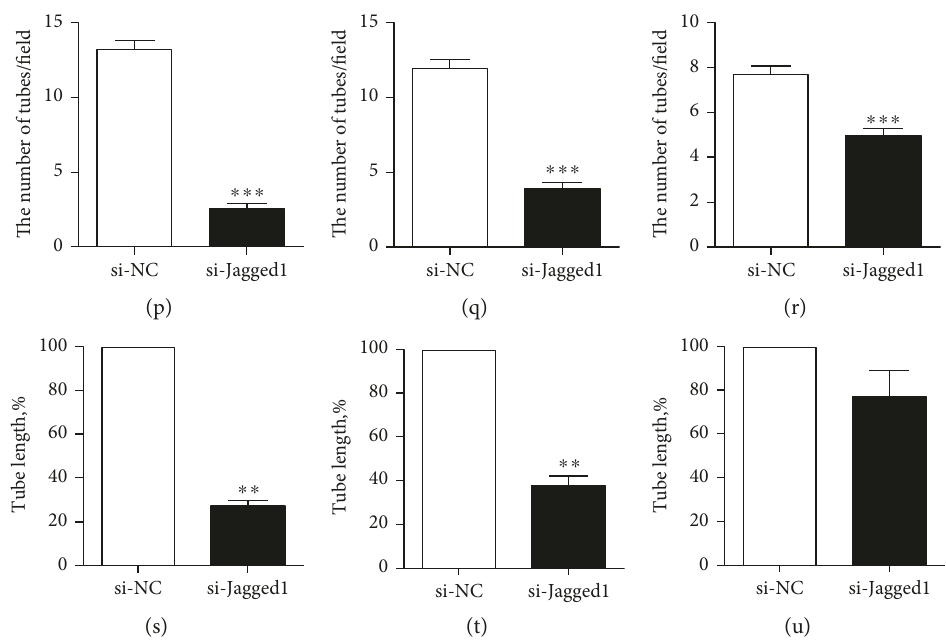
Figure 7: Knockdown of Jagged1 decreased tubule-like structures formation in the umbilical cord artery perivascular stem cells (UCA-PSCs), umbilical cord vein perivascular stem cells (UCV-PSCs), and Wharton ’ s jelly mesenchymal stem cells (WJ-MSCs). (a – i) Jagged1 knockdown was e ff ective. qRT-PCR analysis of Jagged1 mRNA levels in UCA-PSCs (a), UCV-PSCs (b), and WJ-MSCs (c) 48 h after the transfection with negative control siRNA (si-NC) or Jagged1 siRNA (si-Jagged1). ∗∗ P < 0 01 , si-Jagged1 versus si-NC; ∗∗∗ P < 0 001 , si-Jagged1 versus si-NC; ∗ P < 0 05 , si-Jagged1 versus si-NC. Western blot analysis of Jagged1 expression in UCA-PSCs (d), UCV-PSCs (e), and WJ-MSCs (f) 72 h after the transfection with si-NC or si-Jagged1. Quantitative analysis of Jagged1 protein expression levels in UCA-PSCs (g), UCV-PSCs (h), and WJ-MSCs (i) 72h after the transfection with si-NC or si-Jagged1. Data are representative of three independent experiments performed in triplicate, and the expression of targeted protein was relative to the expression of GAPDH protein. ∗∗ P < 0 01 , si-Jagged1 versus si-NC; ∗ P < 0 05 , si-Jagged1 versus si-NC. Knockdown of Jagged1 decreased angiogenesis in UCA-PSCs, UCV-PSCs, and WJ-MSCs in vitro. (j – o) Representative images of tubular structures. Bar: 50 μ m. Tube formation assays were performed 72h after transfection of si-NC or si-Jagged1. The number of tubes in UCA-PSCs (p), UCV-PSCs (q), and WJ-MSCs (r), together with the total length of tubes per fi eld in UCA-PSCs (s), UCV-PSCs (t), and WJ-MSCs (u) were quanti fi ed 3 h after treatment by counting 3 – 5 random fi elds/well under the microscope (magni fi cation: 100x). n = 5 . ∗∗∗ P < 0 001 , si-Jagged1 versus si-NC; ∗∗ P < 0 01 , si-Jagged1 versus